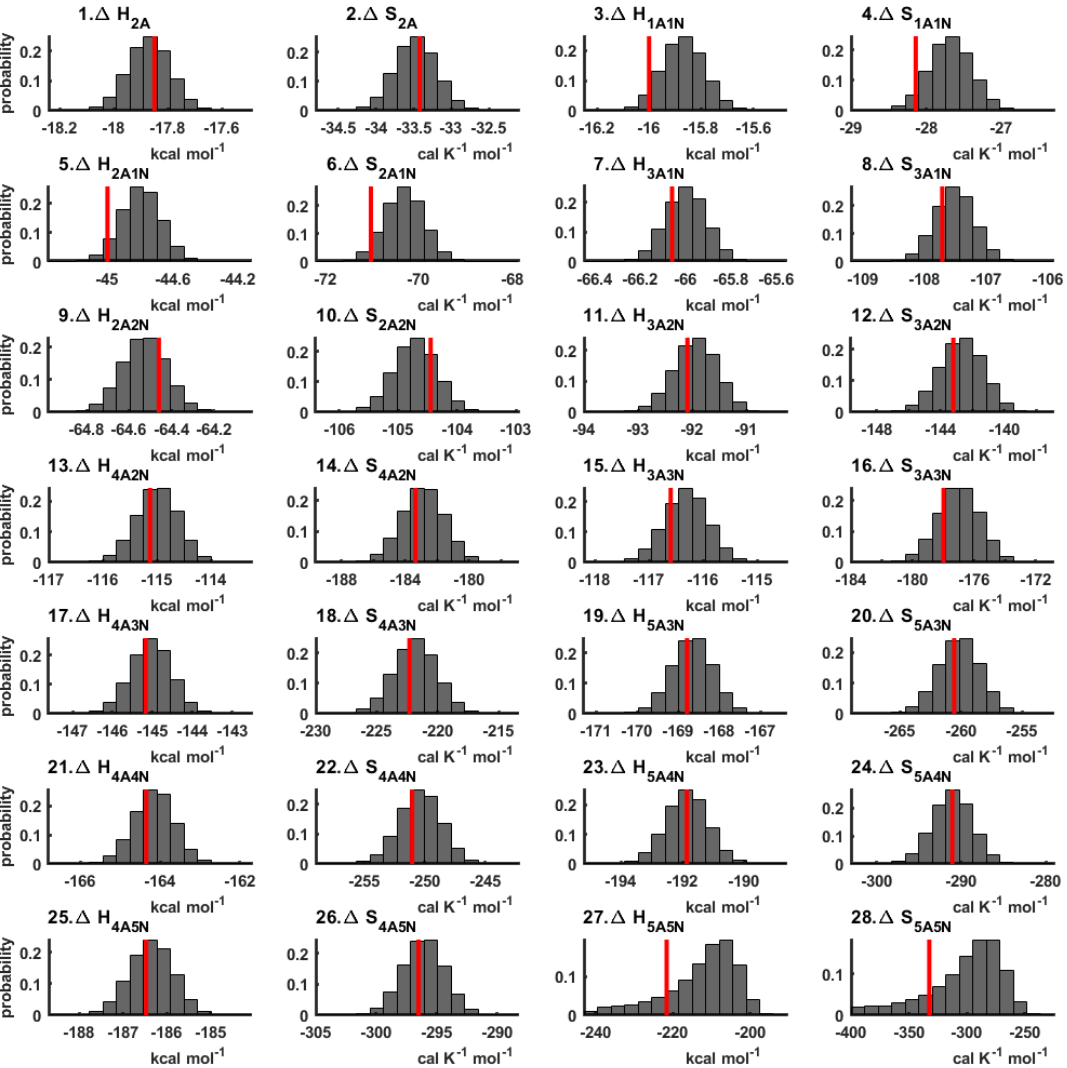
Figure 9. One-dimensional marginal posterior distributions of the cluster formation enthalpies (units given in kcalmol − 1 ) and entropies (units given in calK − 1 mol − 1 ) determined from steady-state cluster concentration measurements at two temperatures ( T = 278K and T = 292K). Red lines denote the baseline values from Olenius et al. (2013b) used to generate the synthetic data. Here, the symbols (cid:49) H and (cid:49) S stand for cluster formation enthalpies and entropies, respectively. The notation xAyN corresponds to a cluster with x sulfuric acid and y ammonia